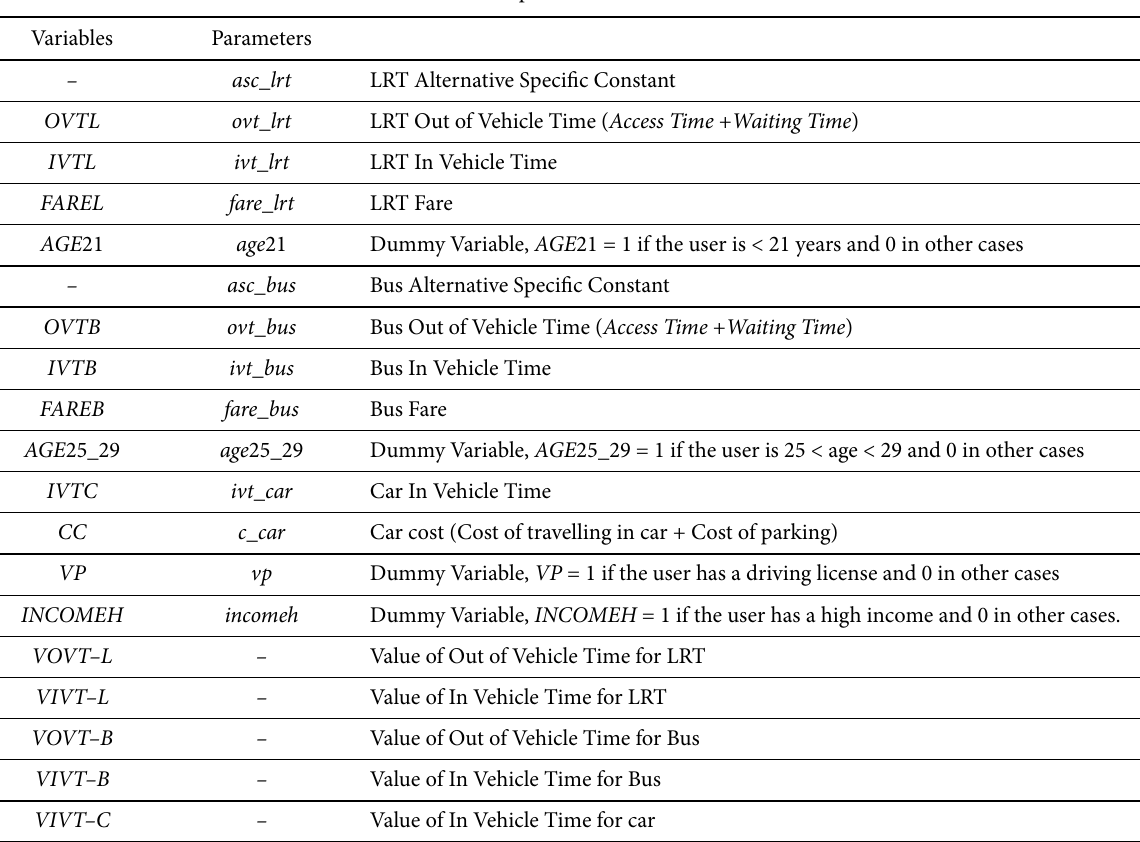
Table A1. Description of the variables